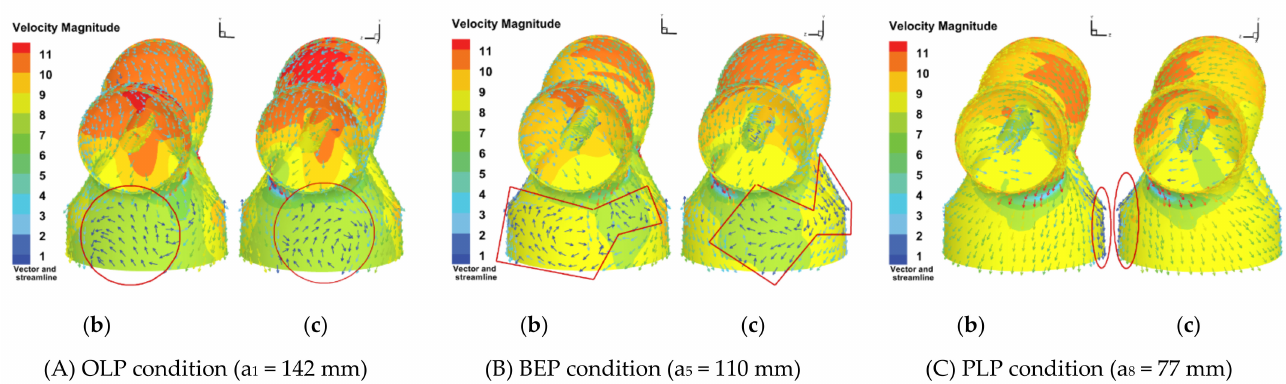
Figure 13. Streamline diagram and surface velocity vector diagram of collection elbow under different working conditions. ( a ) Streamline of cross-section of collection elbow; ( b ) velocity vector diagram from runner I side view; ( c ) velocity vector diagram from runner II side